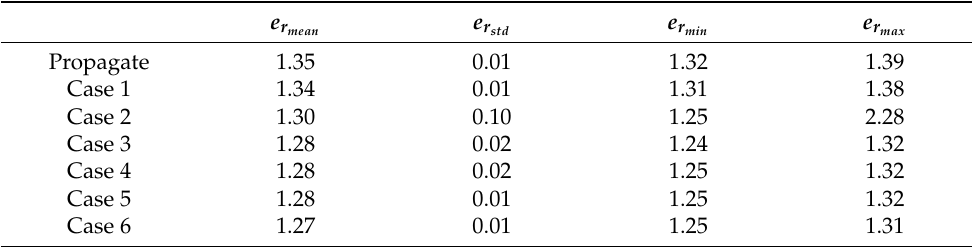
Table 8. Mean position error (m) statistics across 100 simulations of all vehicles for Scenario 2 with only relative position measurements.